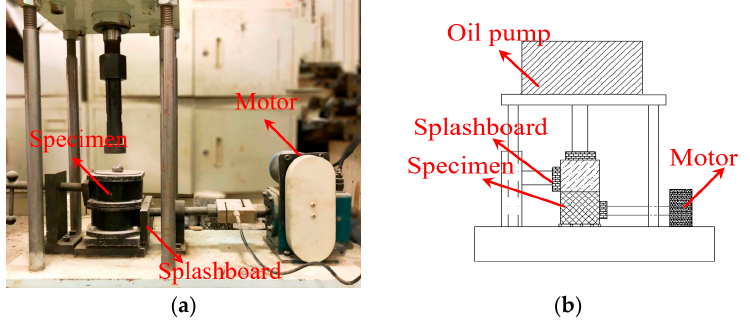
Figure 3. Interlayer material shear tester: ( a ) entity diagram; ( b ) structure diagram.